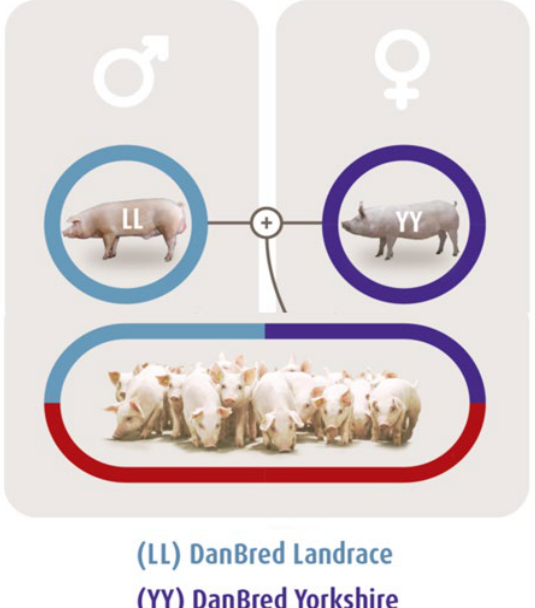
Fig. 1. Scheme of the two-breed crossing of Yorkshire sows with Landrace boars.